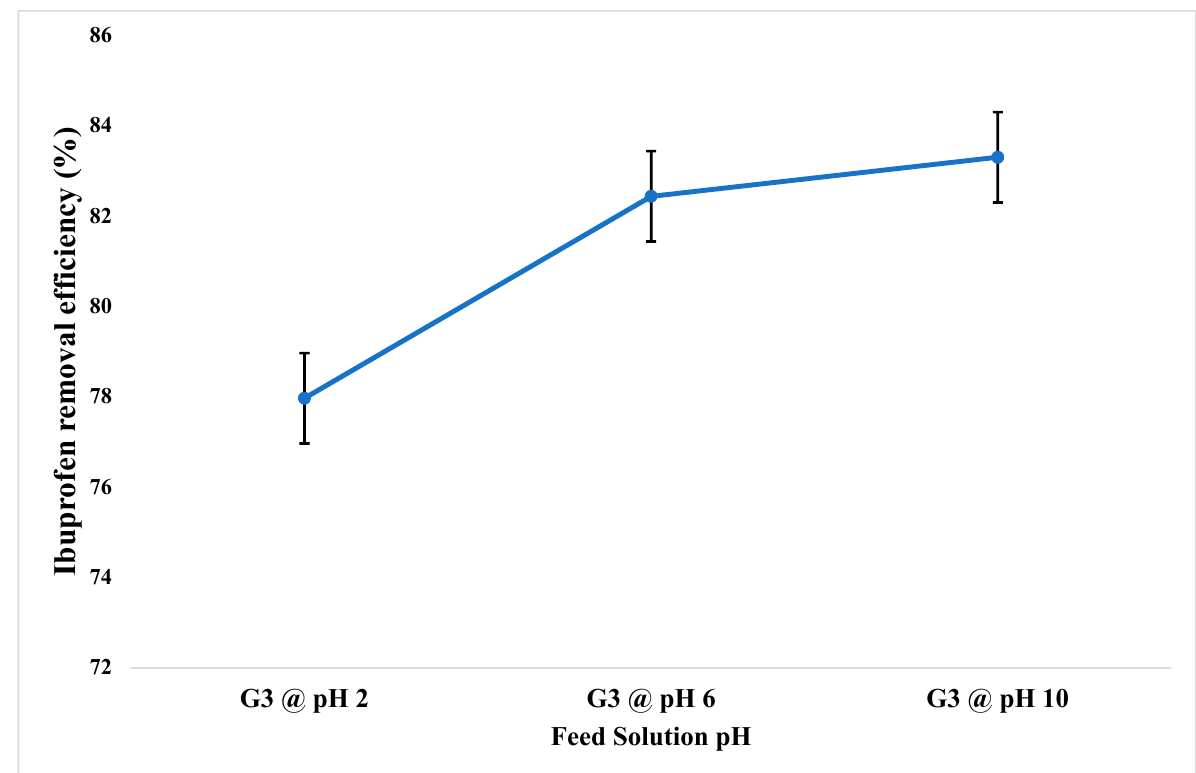
Figure 7. Effect of the pH of the feed solution on Ibuprofen extraction efficiency.